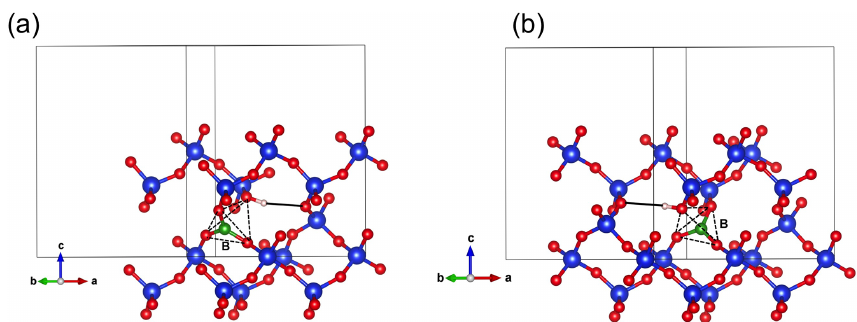
Figure 6. Structure of the (B,OH) defects. Note the location of the B atom on the face of the tetrahedral site. The OH group sits on the opposite corner and points outside of the tetrahedral site (shown by the dotted lines). (a) (B,OH)_1 model; (b) (B,OH)_2